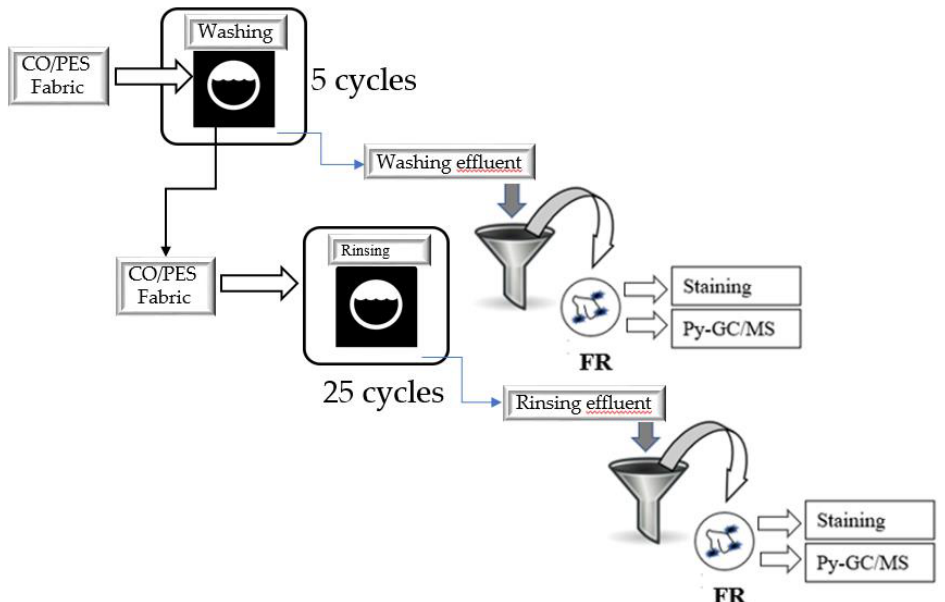
Figure 2. Schematic representation of the washing and rinsing cycles, as well as the collection of effluents for filtration and identification effluents for filtration and identification methods.